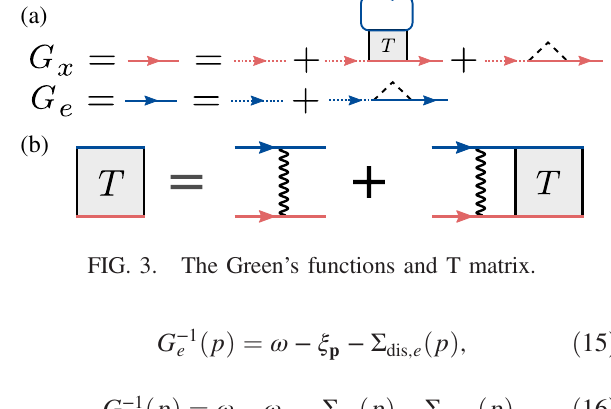
FIG. 3. The Green ’ s functions and T